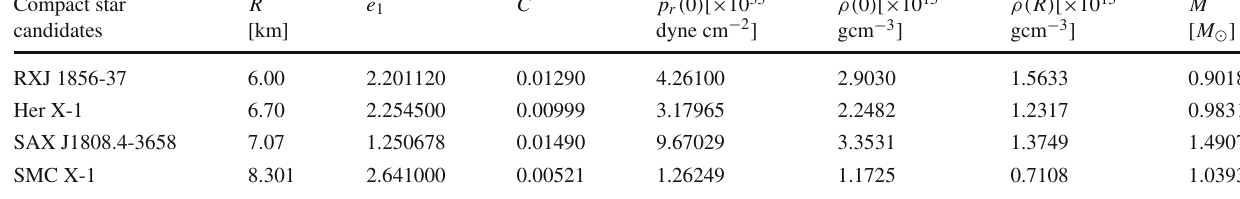
Table 1 Pressure, density and mass for different stellar models Compact star